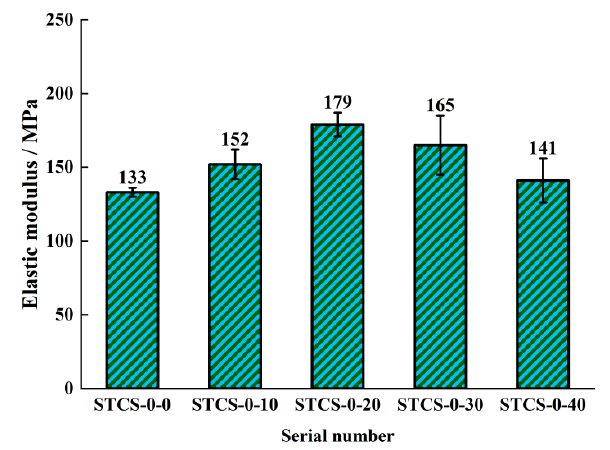
Figure 9. Elastic moduli of TCS.